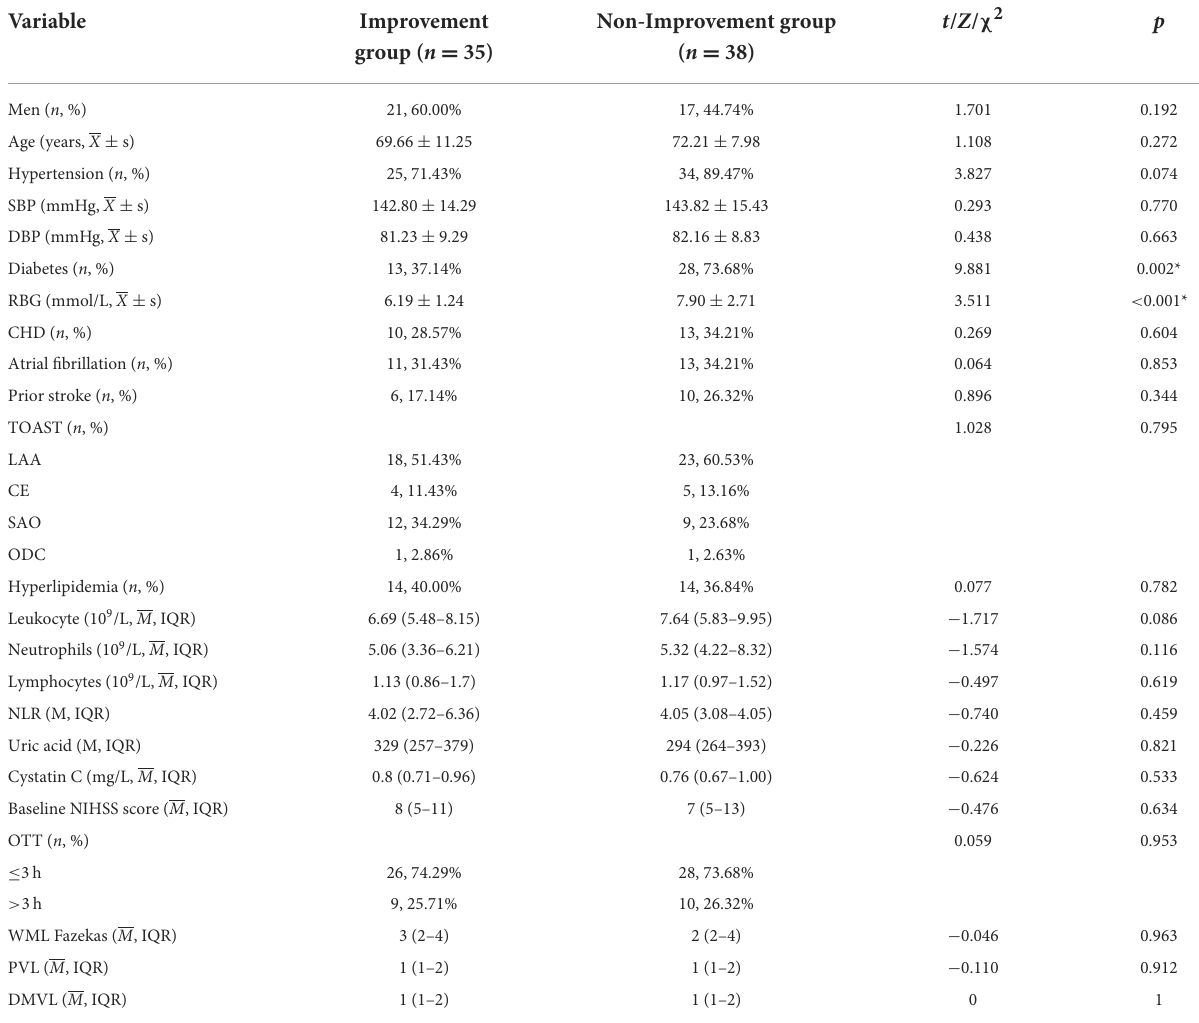
TABLE 2 Baseline characteristics of subgroups based on the presence of post-thrombolysis ENI. Variable